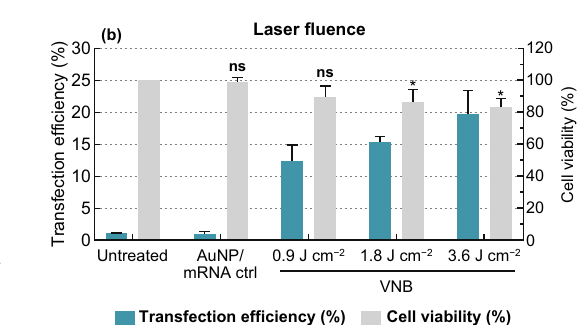
evaluated, i.e., one (0.9 J cm −2 ), twice (1.8 J cm −2 ) and four times (3.6 J cm −2 ) the VNB generation threshold fluence.